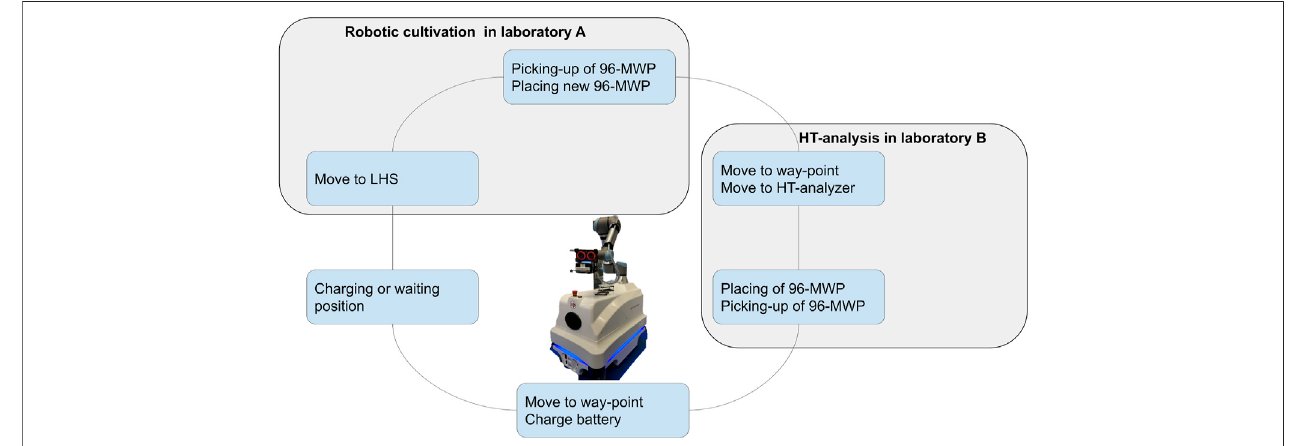
FIGURE 3 | Illustration of the mobile robotic work fl ow. The mobile robotic lab assistant connects the cultivation platform in laboratory A with the high-throughput analyzerinlaboratoryB. Theestablishedwork fl owforthetransportation of96-microwellplatesconsistingofthefollowingsteps:1)move 96-MWPplatefromtheLHSto mobile robotic lab assistant, 2) place new 96-microwell plate from mobile robotic lab assistant back-shelf to LHS, 3) go to waypoint, 4) go to HT analyzer, 5) place 96- MWP on rack in HT analyzer, 6) remove 96-MWP from HT analyzer, 7) go to waypoint, and 8) charge battery. MWP, microwell plate; HT, high-throughput; LHS, liquid handling